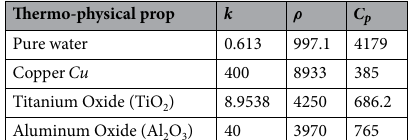
Thermo-physical